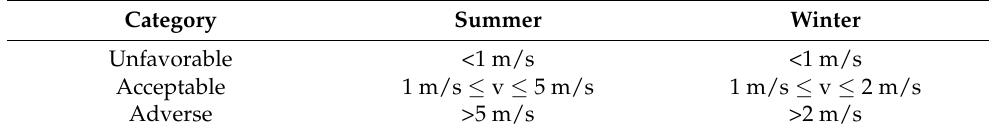
Table 2. Wind speed table for outdoor comfort in Nanjing.